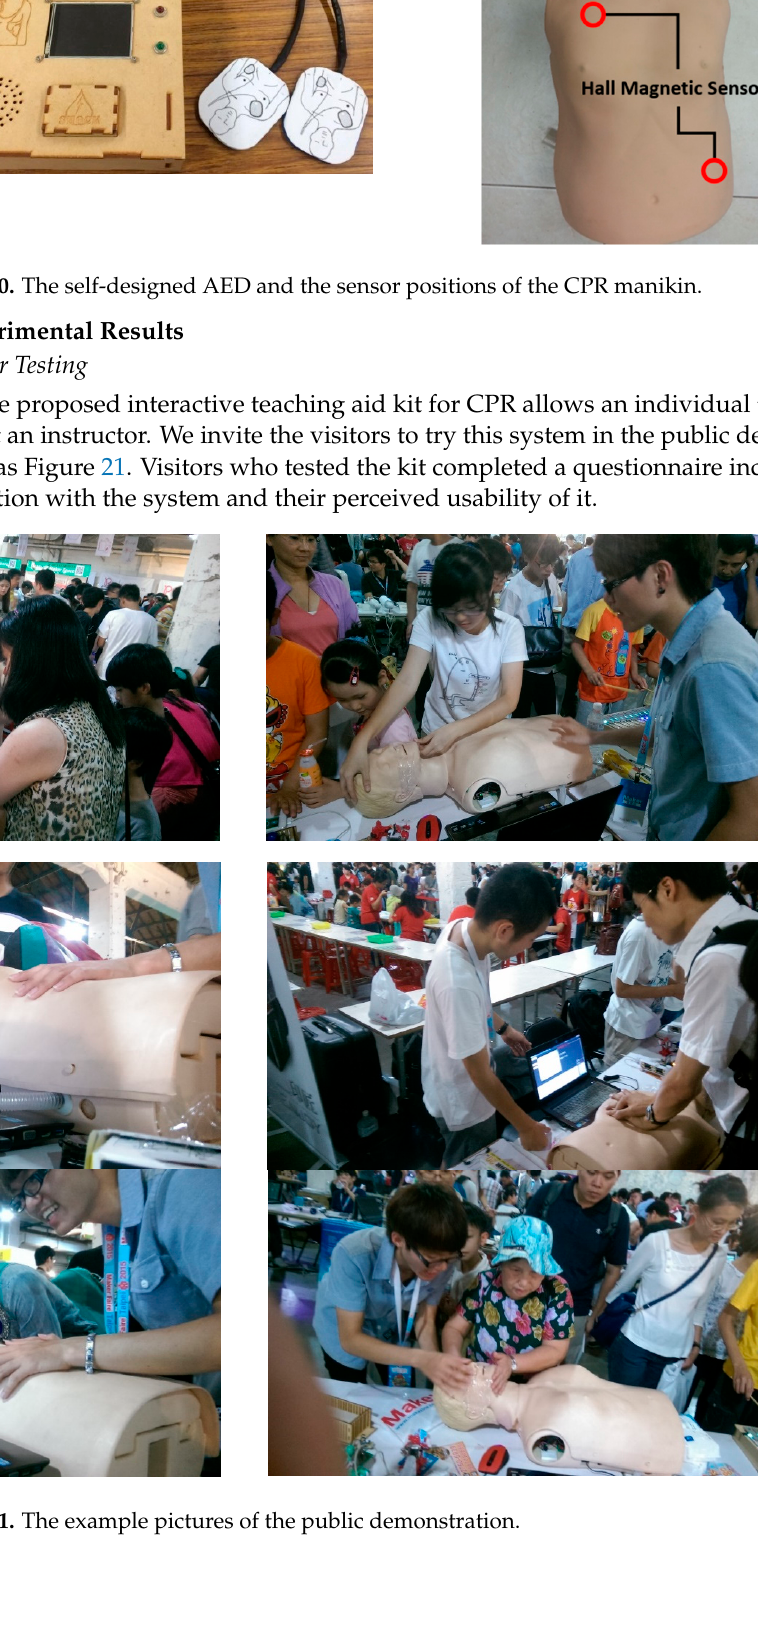
Figure 19. The magnetic sensors and LED indicator bars installed beneath the skin of the manikin.